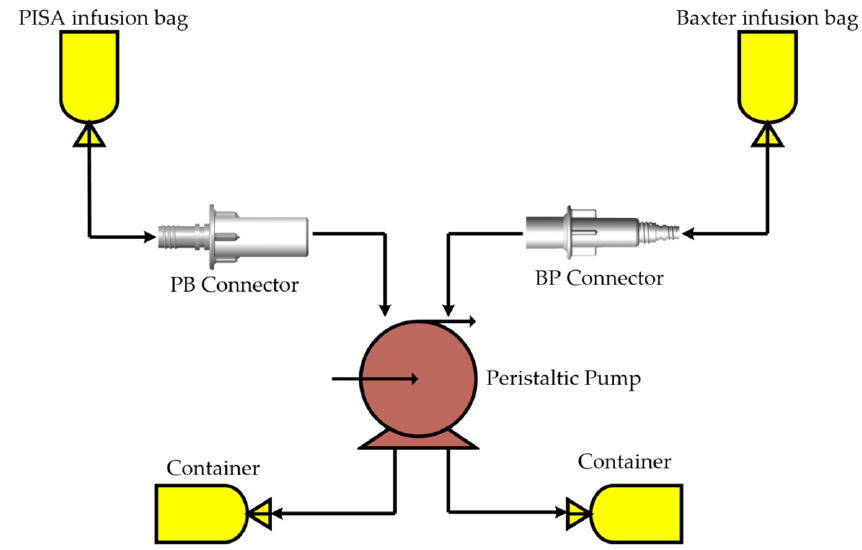
Figure 10. Titanium connectors linked with equipment from different brands.